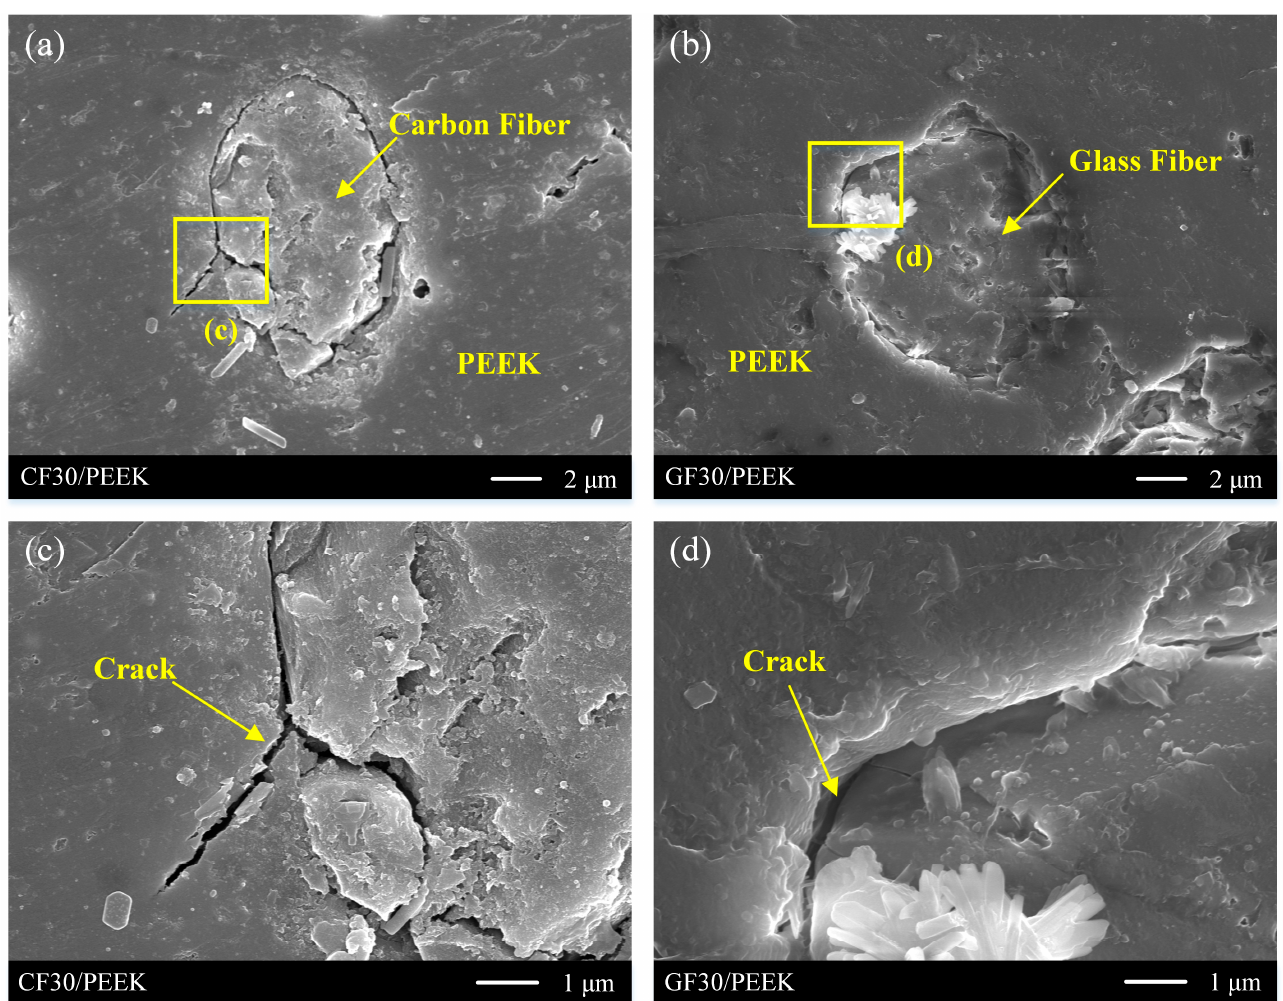
Figure 9. Crack morphologies of different sample: ( a ) CF30/PEEK; ( b ) GF30/PEEK; ( c ) amplified morphology of CF30/PEEK; ( d ) amplified morphology of GF30/PEEK.